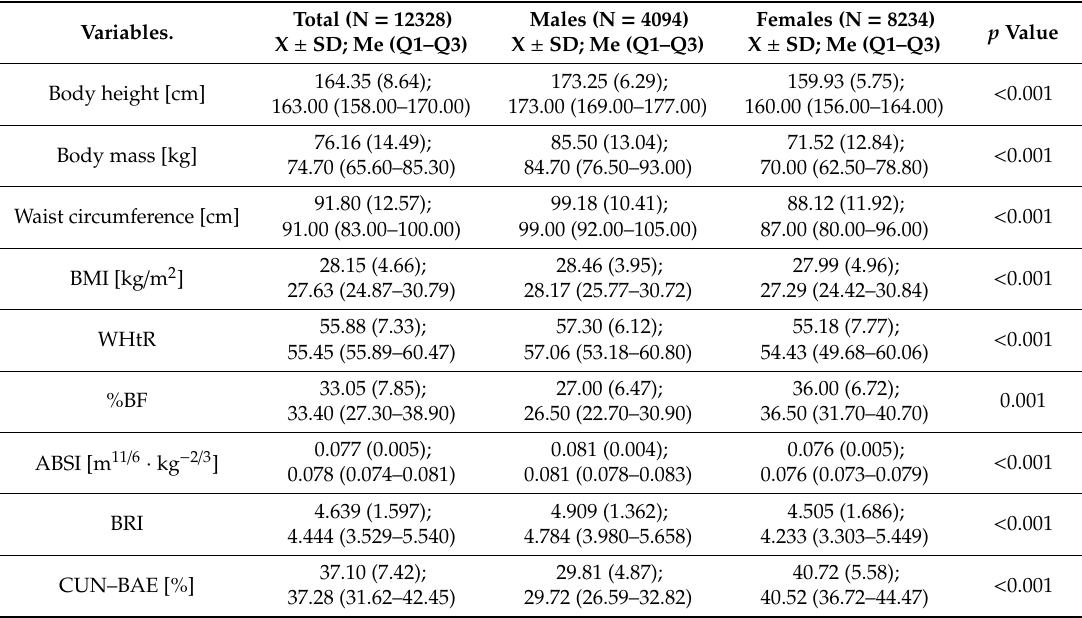
Table 1. Anthropometric measurements and adiposity indexes of the subject groups.